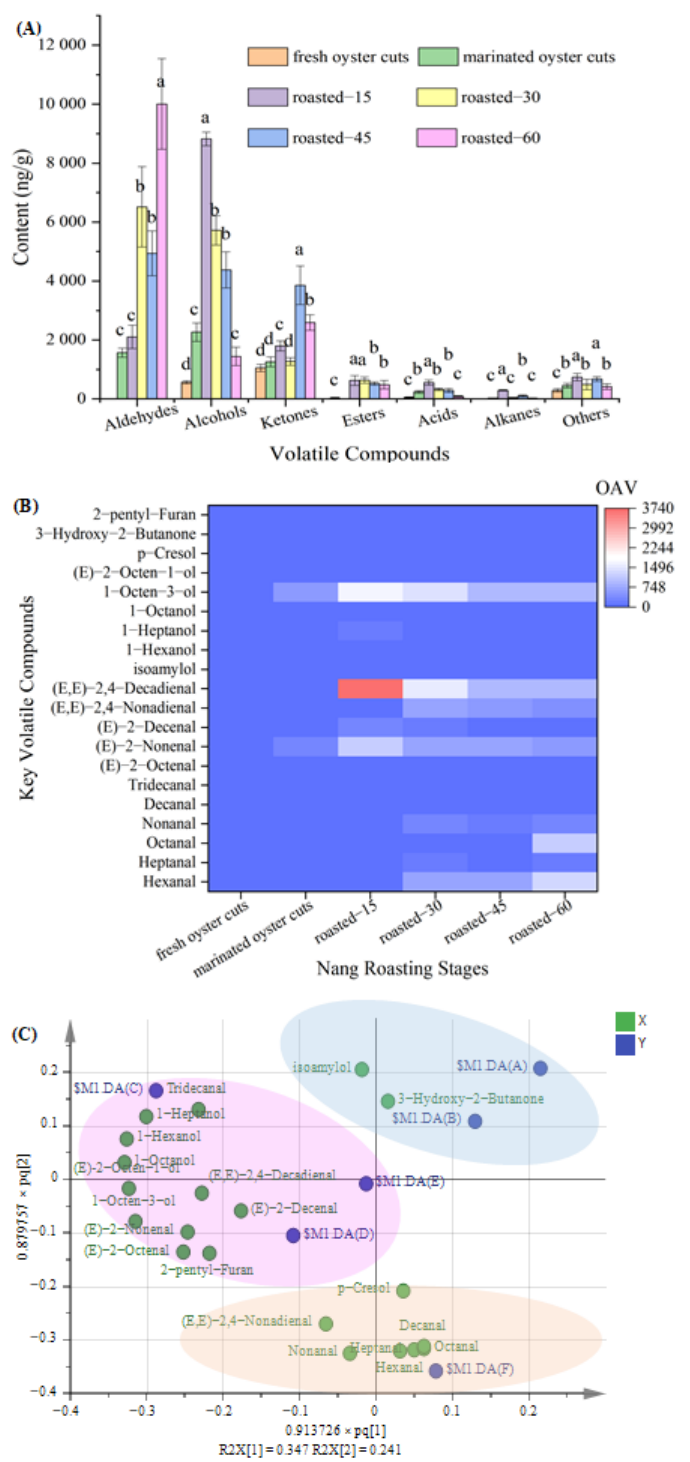
Figure 1. Distribution of volatile compounds groups ( A ), heatmap analysis of volatile compounds with odor activity value (OAV) > 1 ( B ) and orthogonal partial least square discriminant analysis (OPLS-DA) based on volatile compounds with OAV > 1 in Nang roasted oyster cuts ( C ). $M1.DA(A), fresh oyster cuts; $M1.DA(B), marinated oyster cuts; $M1.DA(C), $M1.DA(D), $M1.DA(E) and $M1.DA(F) means roasted-15, roasted-30, roasted-45 and roasted-60, respectively. X: volatile flavor compounds (OAV > 1), Y: Nang roasting stages. Different lowercase letters in the same row indicate that there is significant difference ( p < 0.05).